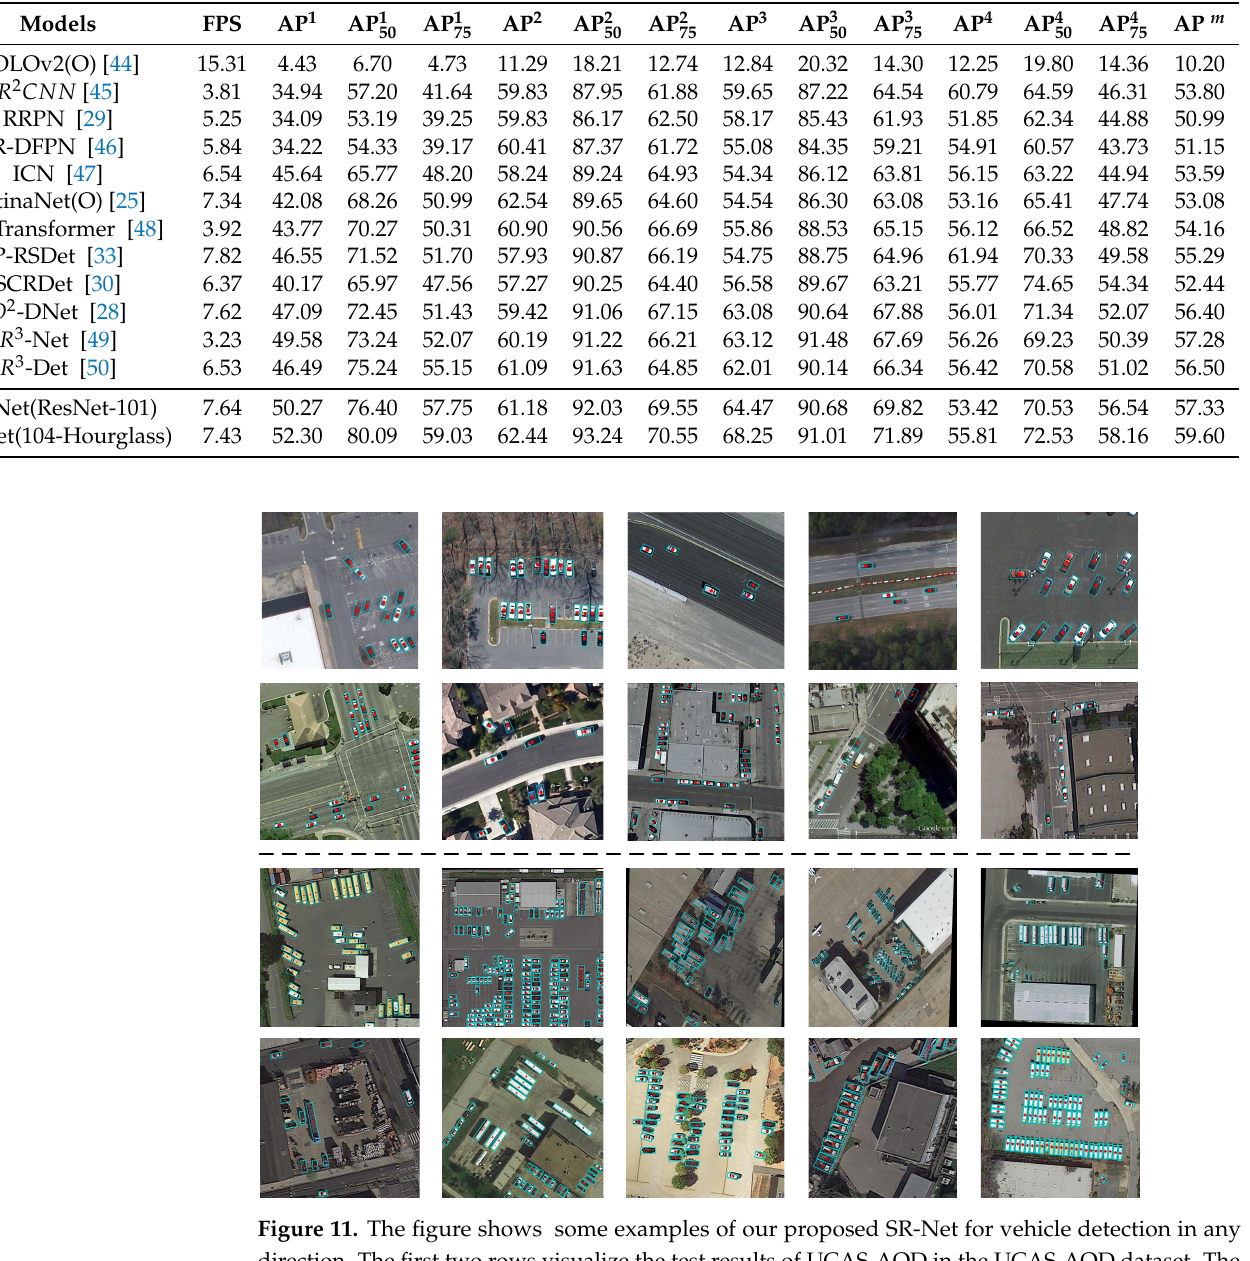
Table 2. State-of-the-art comparisons. AP is the average of 10 values of AP taken between iou = 50 and iou = 95. AP 1 denotes the AP value obtained in the DOTA validation set, AP 2 denotes the AP value obtained in the UCAS-AOD test set, AP 3 denotes the AP value obtained in the DLR 3K Munich dataset test set, and AP 4 denotes the AP value obtained in the VEDAI test set. AP m denotes the average of the AP values obtained in the four datasets. AP 50 is the AP value obtained in the IoU = 50, and AP 75 is the AP value obtained at IoU = 75.